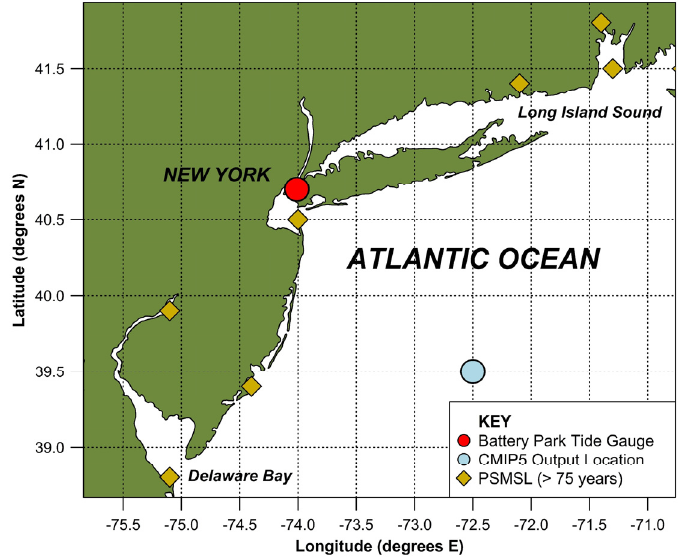
Figure 1. Location of data sources used in the study.